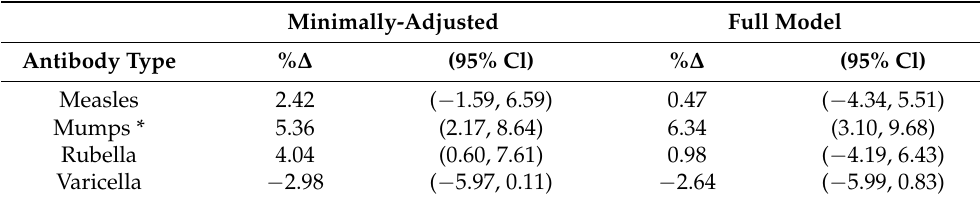
Table 3. Percent difference in antibody concentration (% ∆ ) per interquartile range increment in dietary fiber intake (and 95% confidence